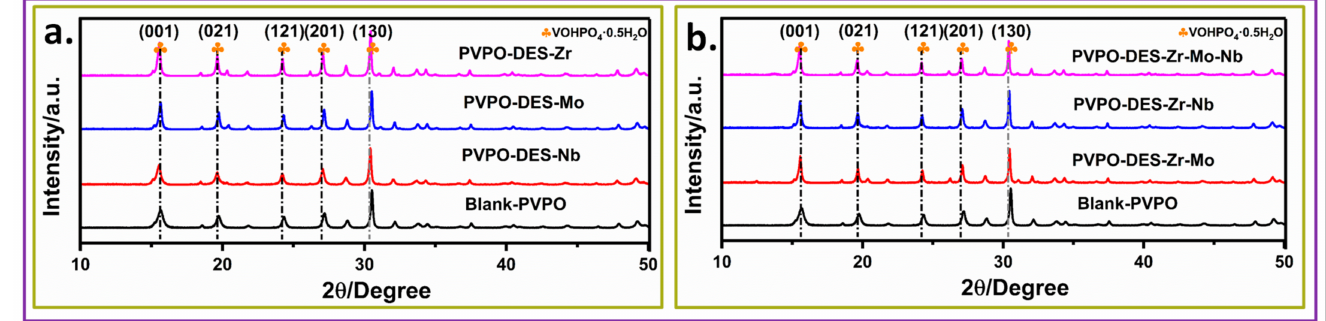
Figure 4. XRD spectra of mono- ( a ), and bi- and tri-metallic precursors (PVPO) ( b ) for identifying the main precursor phase VOHPO 4 · 0.5H 2 O.